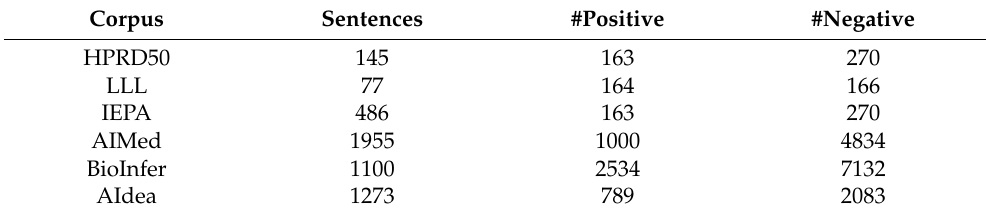
Table 2. PPI corpora statistics.